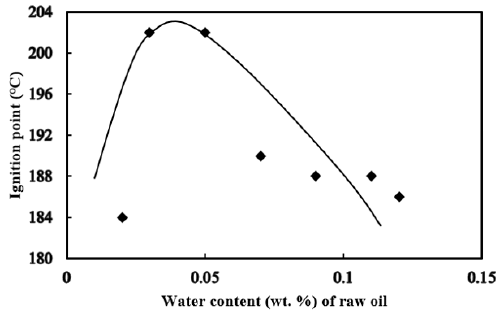
Figure 6. Effects of added water content in palm oil on the ignition point of the biodiesel product.